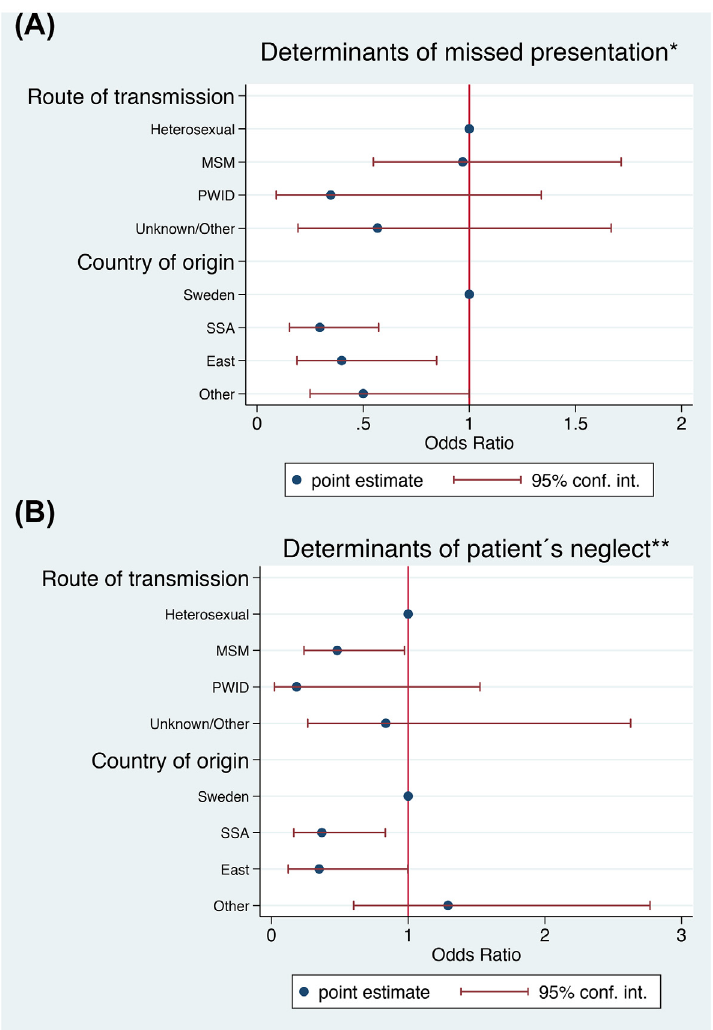
** The model was adjusted for: